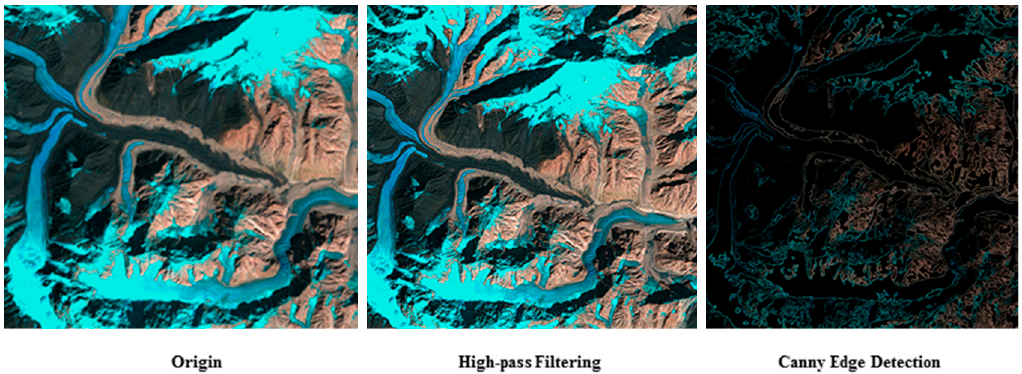
Figure 13. Origin, high-pass filtering, and Canny edge detection. Remote Sens. 2020 , 12 , 607